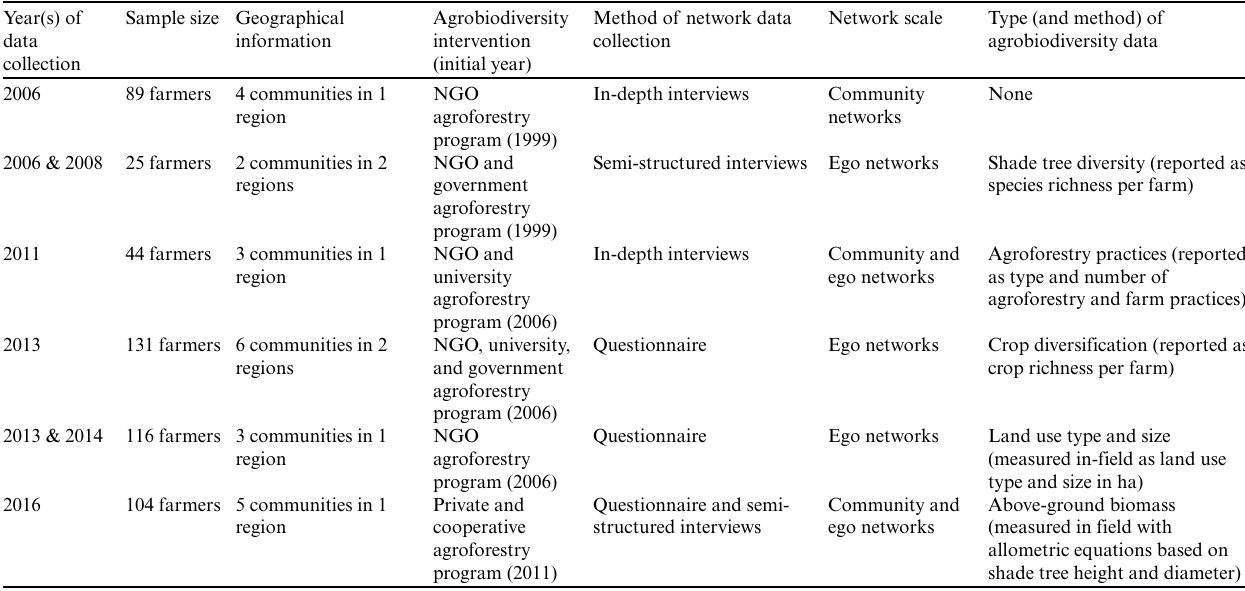
Table 1 . Overview of field studies on agroforestry interventions from 2006 to 2016 in the cocoa-growing region of Ghana.* Year(s) of data